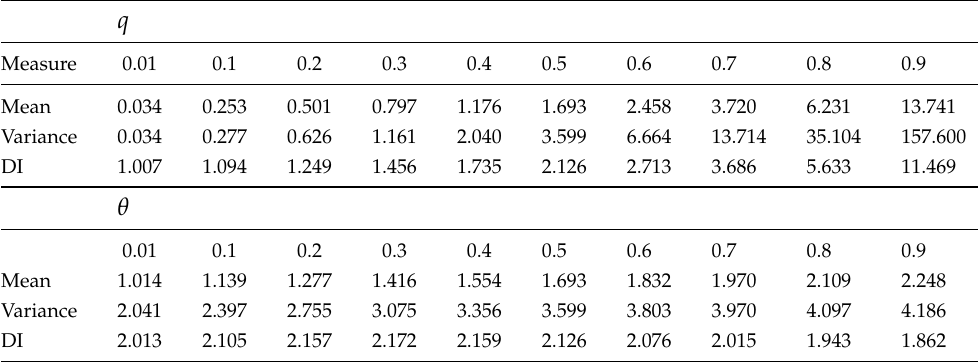
Table 1. Some numerical measures of the TRTG model for θ = 0.5 and q =